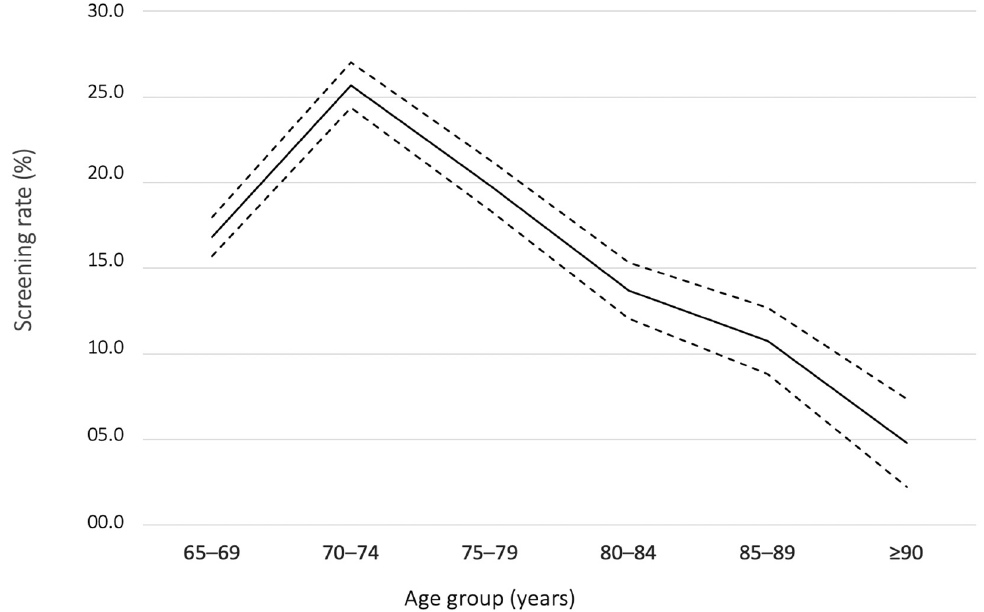
Figure 2. Atrial Fibrillation screening rates according to age group for all participants. The continuous line represents the value of the screening rate in percentage and dotted lines show the upper and lower limits of the 95% confidence interval.